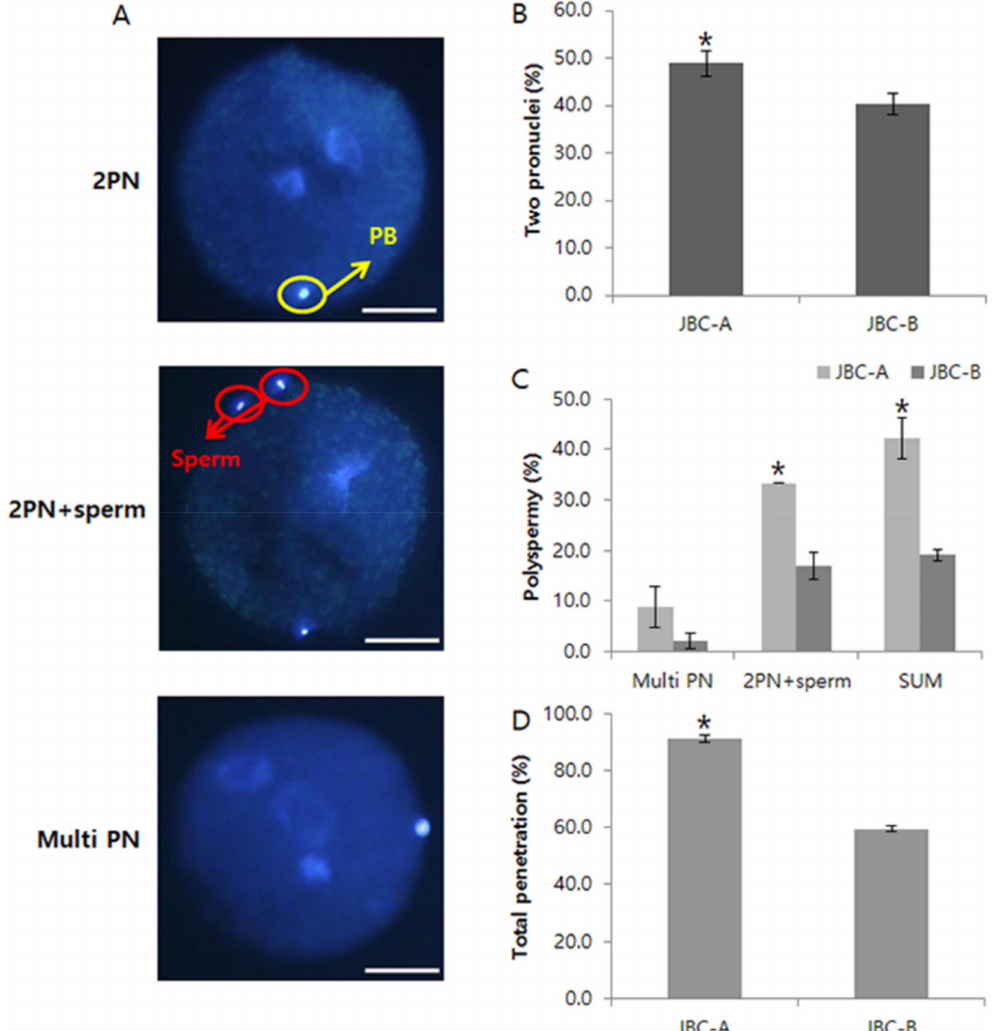
Figure 4. Nuclear status of bovine embryos at 18 h after in vitro fertilization. ( A ): Pronuclear status of bovine zygotes. ( B ): Percentage of zygotes with two pronuclei. ( C ): Percentage of zygotes with polyspermy. ( D ): Percentage of zygotes showing total penetration. Data shown are the mean ± SEM of three independent replicates per group. * p < 0.05. Scale bars = 30 µ